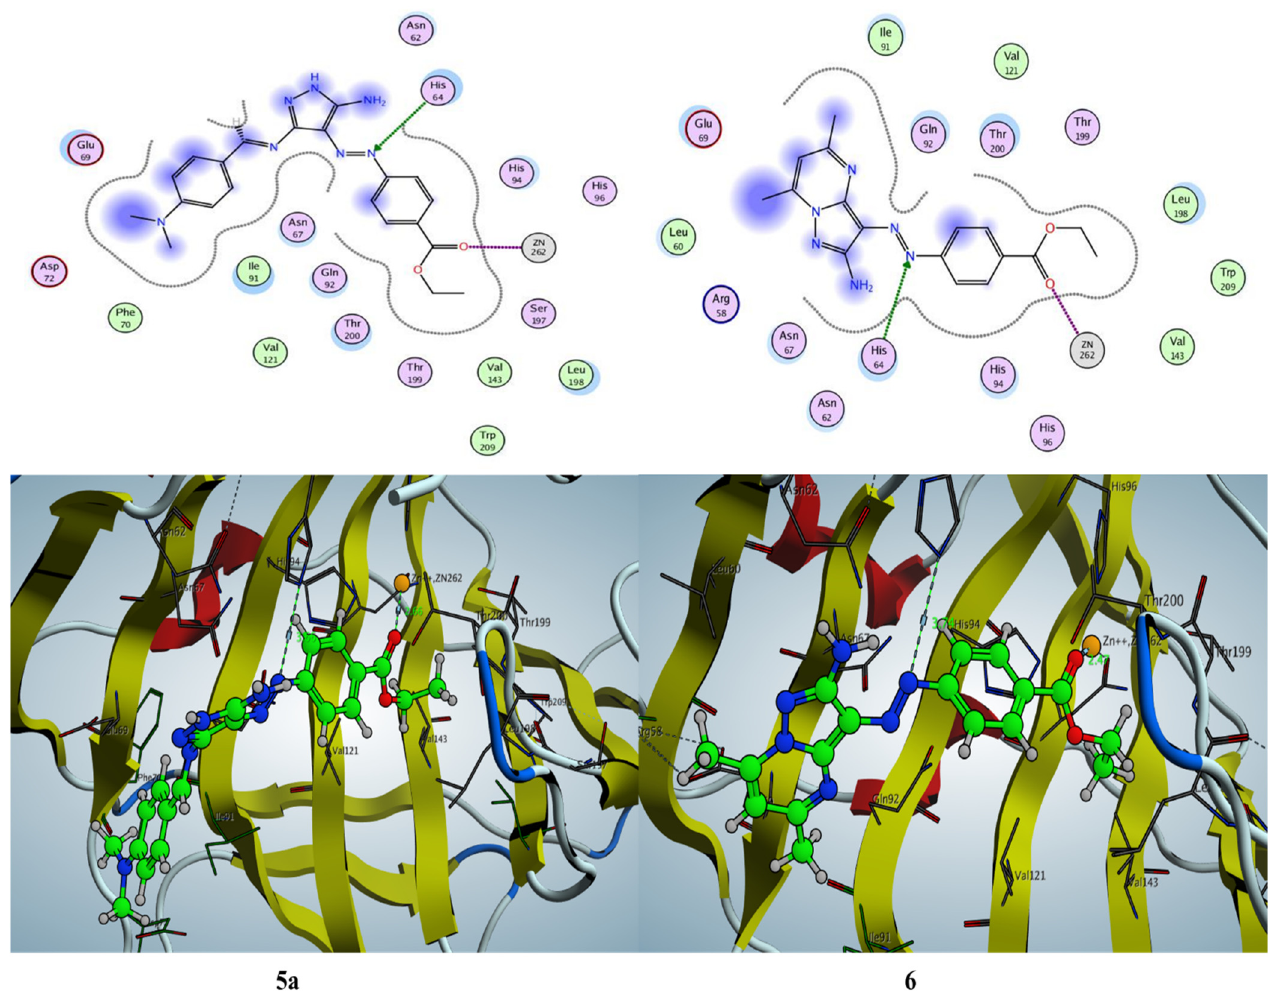
Figure 11. 2D and 3D enzyme–ligand interaction of compounds 5a and 6 inside the active site of h CA-II.